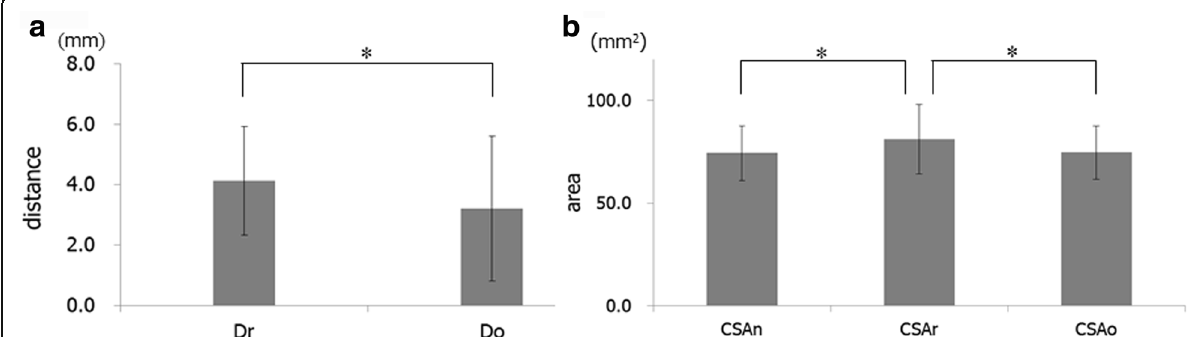
Fig. 5 a Statistical comparison of the distance from the left maxillary incisor to the incisive canal at level-r (Dr) and level-o (Do) (mm). b Statistical comparison of the area of the incisive canal at level-n (CSAn), level-r (CSAr), and level-o (CSAo) (mm 2 ). * p <